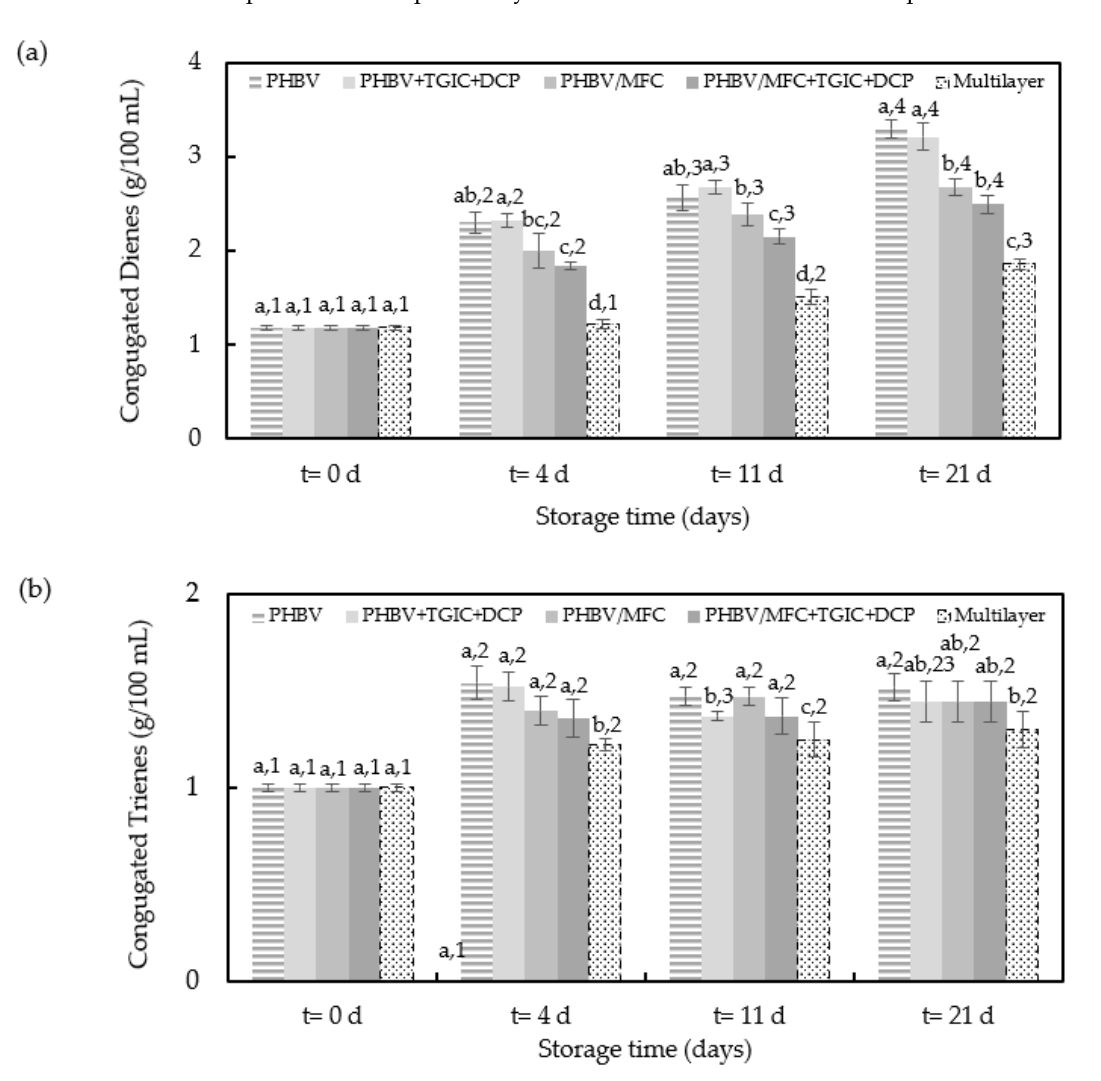
Figure 7. Conjugated dienes ( a ) and trienes ( b ) during accelerated storage conditions of the sunflower oil samples packaged in trays with the green composite lid films of poly(3-hydroxybutyrate- co -3-hydroxyvalerate) (PHBV) with microfibrillated cellulose (MFC) and compatibilized with triglycidyl isocyanurate (TGIC) and dicumyl peroxide (DCP) and the multilayer commercial film. Different superscripts (a–c) indicate significant differences among samples for the same storage time and different superscripts (1–4) indicate differences due to storage time for the same sample ( p < 0.05).